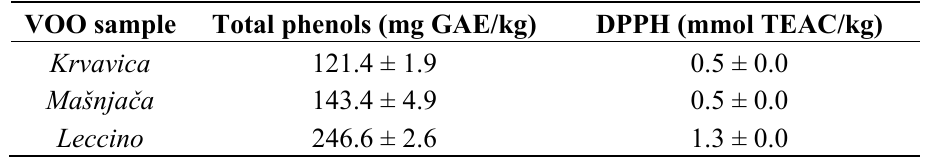
All values are expressed as mean of triplicate determinations ± SD.